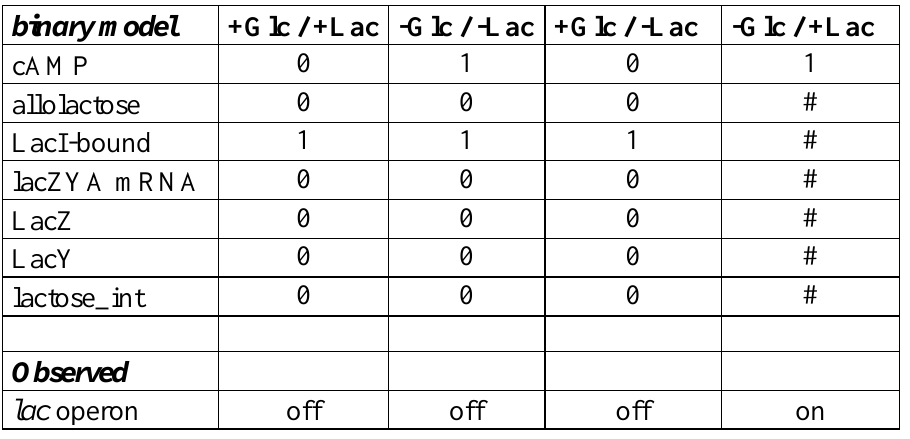
Table 3: Logical steady states for the key nodes in the binary model and the observed lac operon state for four different scenarios with glucose/lactose as